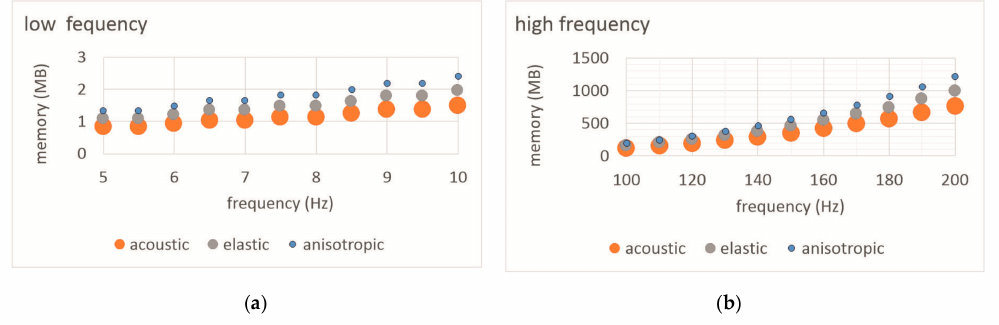
Figure 12. The relationships between the memory workout and source frequency for: low ( a ) and high ( b ) frequencies of the source wavelet.